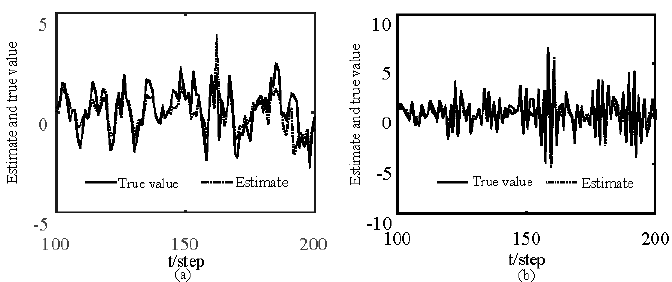
. Sensors 2019 , 19 , x FOR PEER REVIEW 16 of 19 Q . Figure 4. Identification of noise variances Q V Q . i i V i V